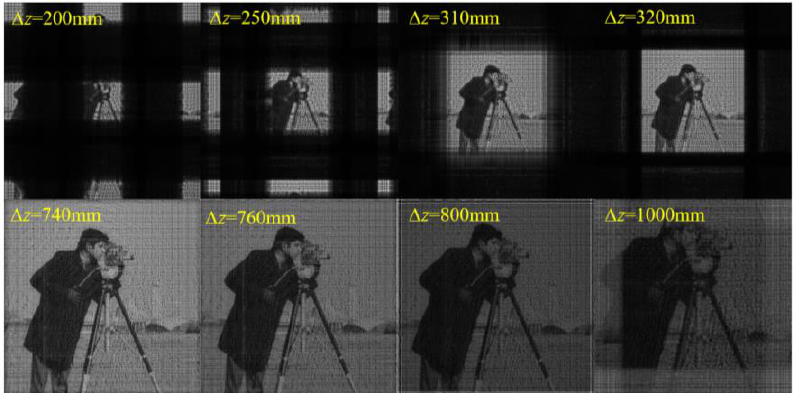
Figure 9. Calculated amplitude distributions on the diffraction plane with different ∆ z using DBFT.